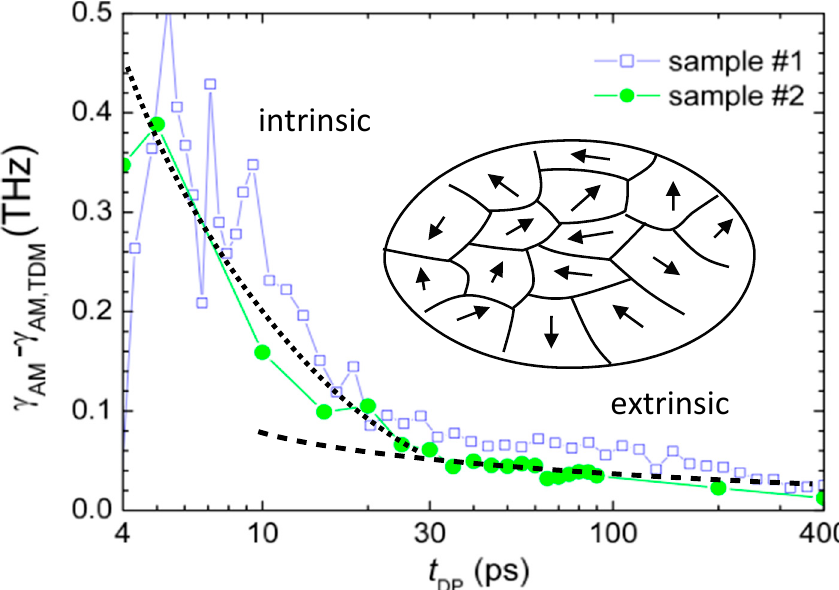
Figure 3. Incoherent relaxation of domains in photoexcitation experiments. The time-dependence of the excess linewidth γ AM − γ TDM due to the annihilation of topological defects. Here, γ AM is the full linewidth, and γ TDM is the thermal linewidth. Data for two different samples show a difference primarily in the long-time behavior beyond 30 ps, which appears as an offset. The insert depicts the laser photoexcitation spot where the phase of the order parameter is represented schematically by arrows.